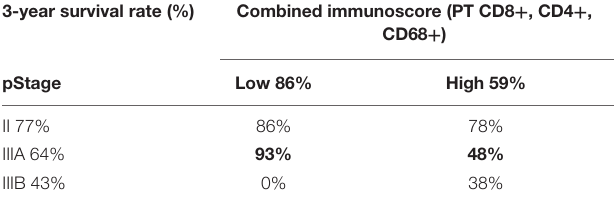
TABLE 4 | Three-year survival rates in different subgroups defined by the integration of combined immunoscore with Tumor, Node, Metastasis (TNM) stage classification: On the first column, 3-year survival rates according to stages I, II, and III are reported. 3-year survival rate